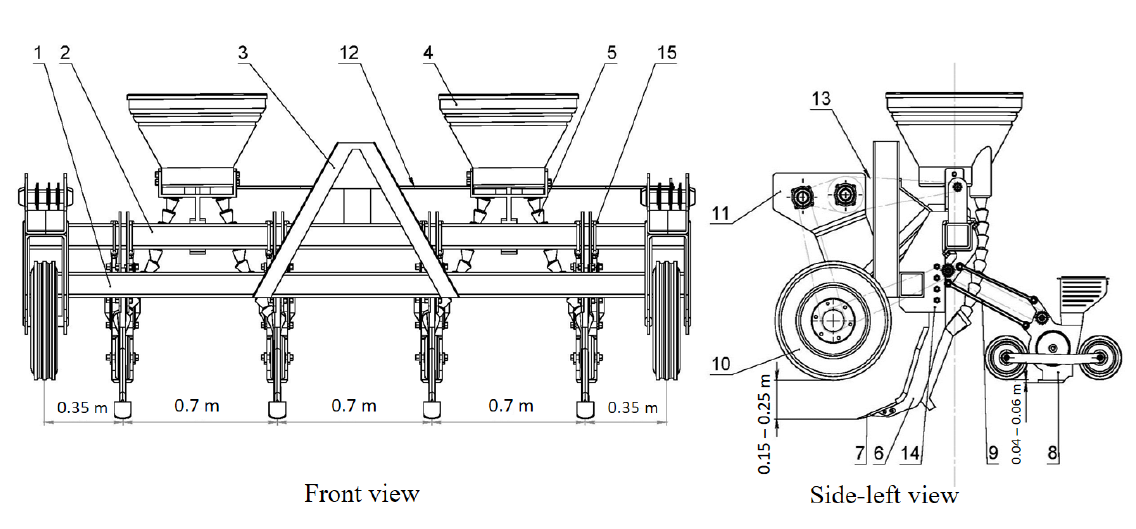
Figure 2: Schematic diagram of the prototype